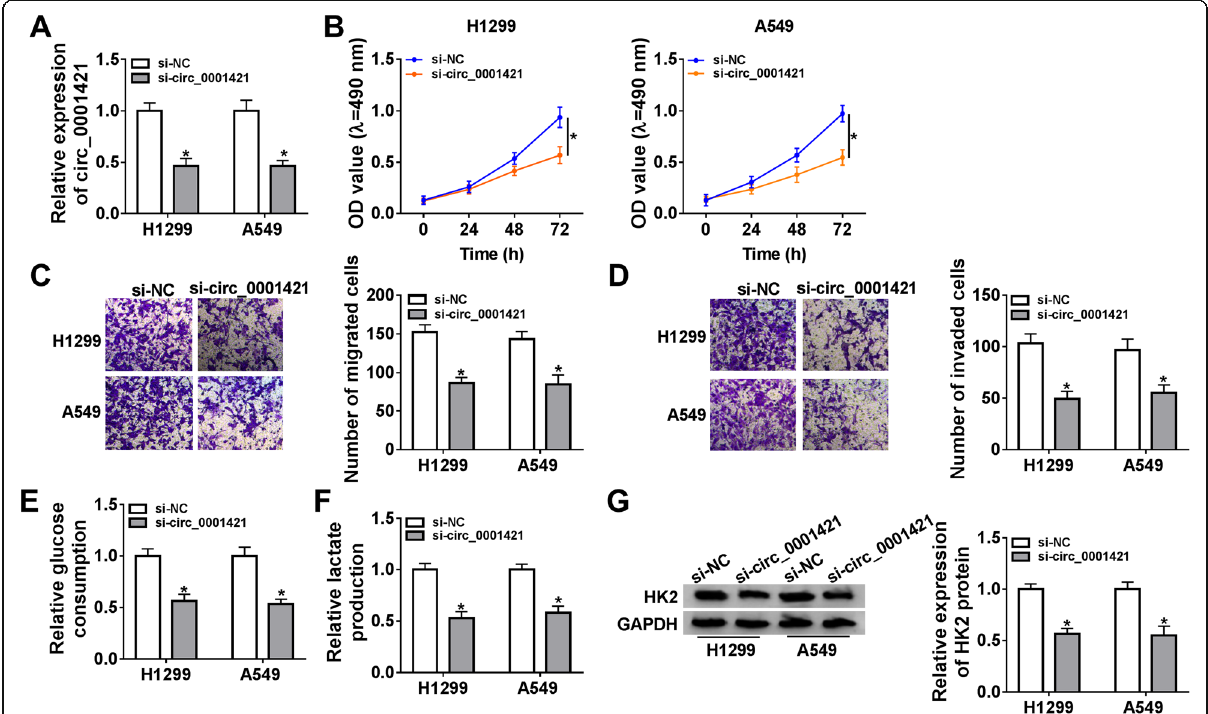
Fig. 2 Knockdown of circ_0001421 repressed LC cell proliferation, migration, invasion and glycolysis in vitro. H1299 and A549 cells were transfected with si-NC or si-circ_0001421. a Circ_0001421 expression was measured by qRT-PCR. b MTT assay was performed to assess cell proliferation. c-d Cell migration and invasion were determined by Transwell assay. e-f Glucose consumption and lactate production were examined by a Glucose assay kit and a Lactic Acid assay kit. g Western blot was performed to measure the protein expression of HK2. * P <